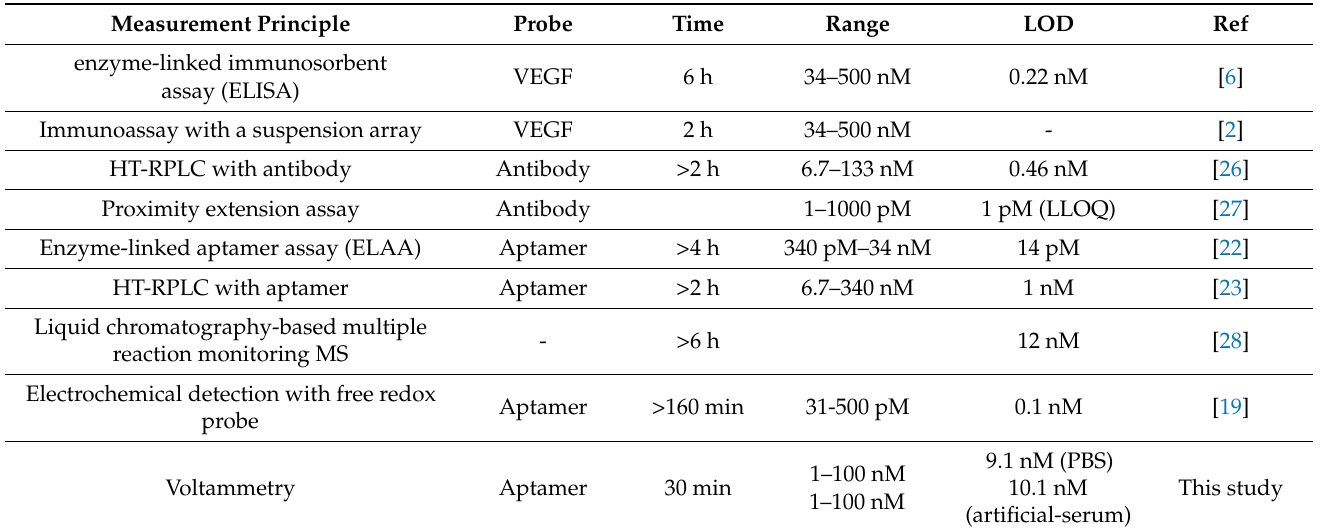
Table 1. Comparison of previously reported sensing principles for bevacizumab and this